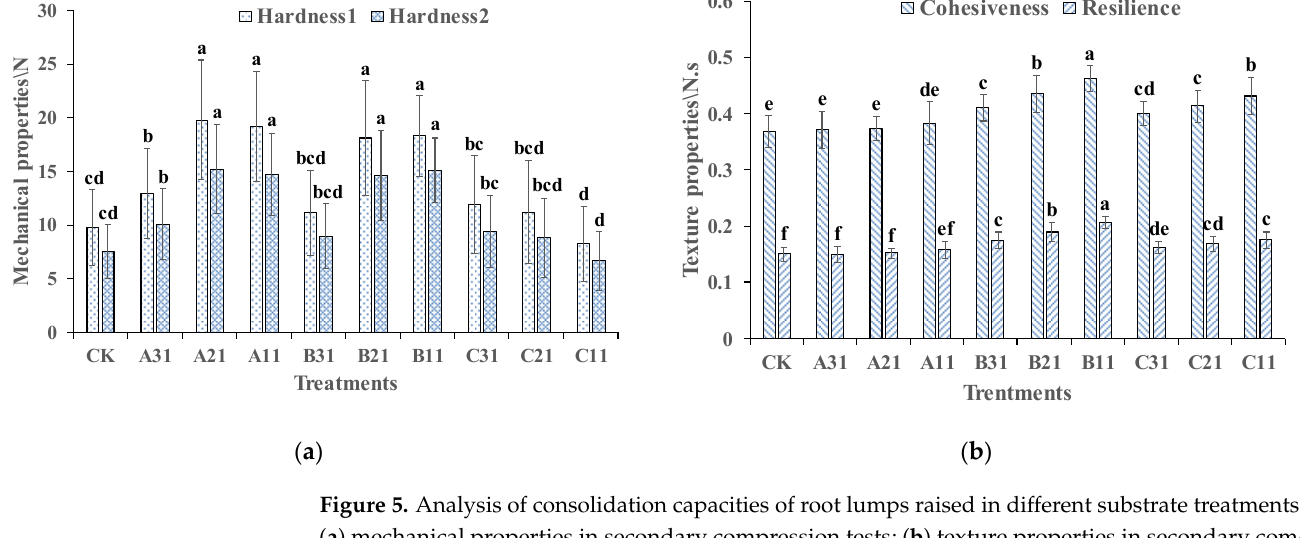
Figure 5. Analysis of consolidation capacities of root lumps raised in different substrate treatments: ( a ) mechanical properties in secondary compression tests; ( b ) texture properties in secondary compression tests.